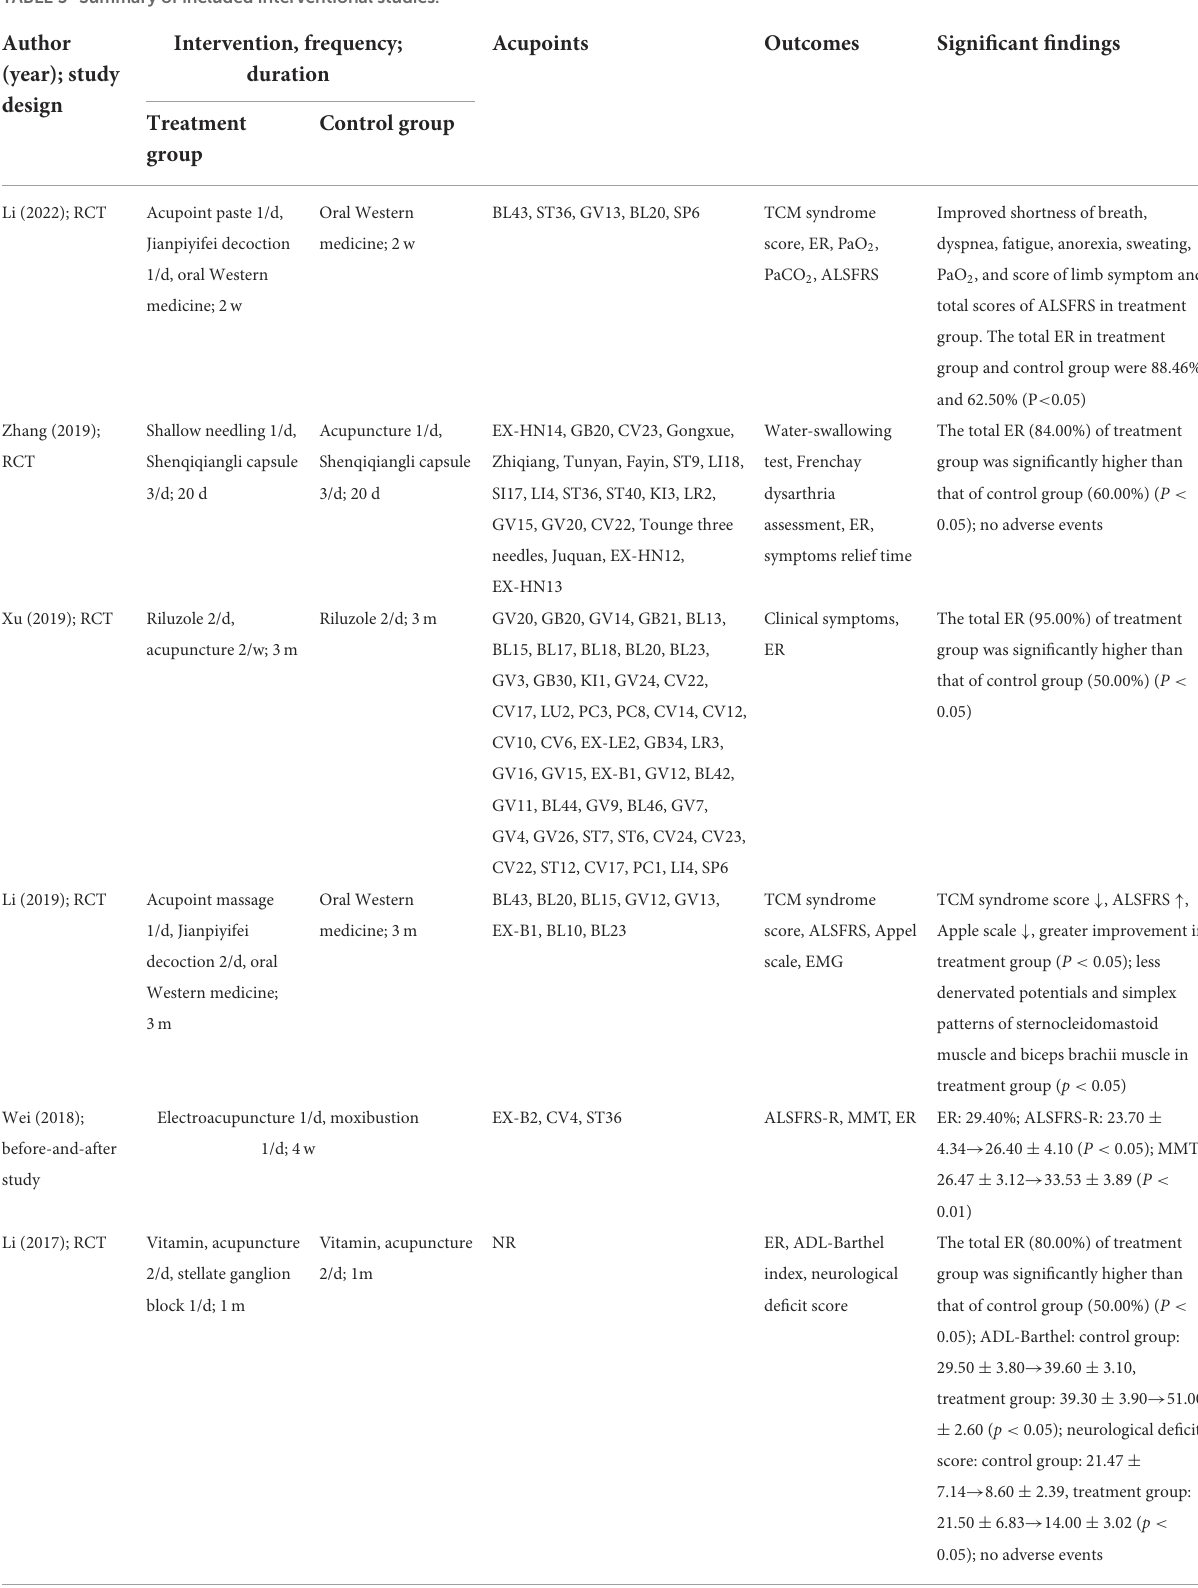
TABLE 5 Summary of included interventional